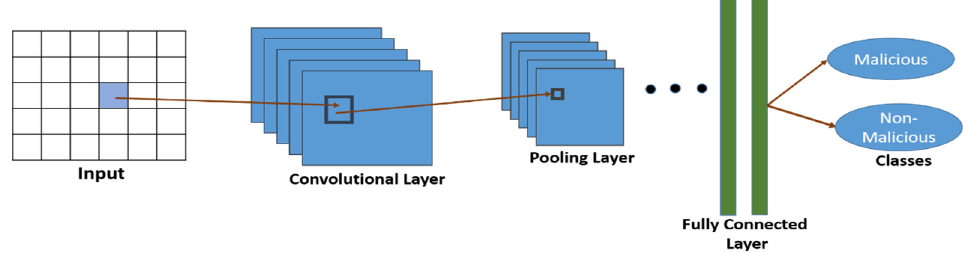
Figure 5. The Convolutional Neural Network (CNN) architecture comprises of a stack of Convolutional layer, Nonlinear layer rectified linear activation unit (ReLU), Pooling layer, and a Loss function (like Softmax) on the last fully connected layer.